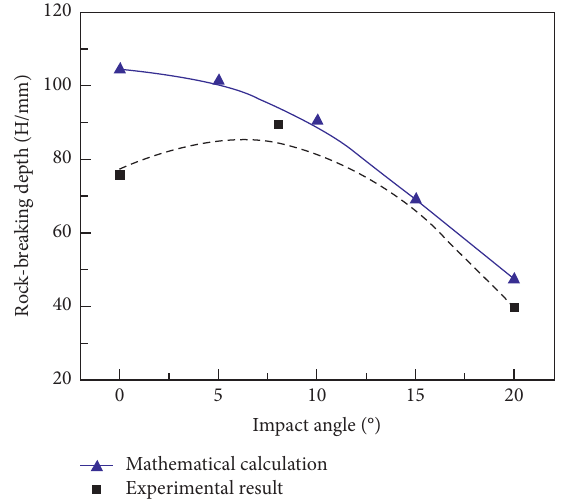
Figure 9: Effect of impact angle on rock-breaking depth (test time with 60s; particle diameter with 1.0mm; water-jet impact velocity with